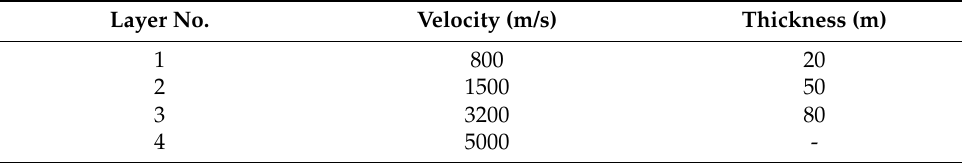
Table 2. The dimension and position of the four local anomalies. Anomaly No. Anomaly